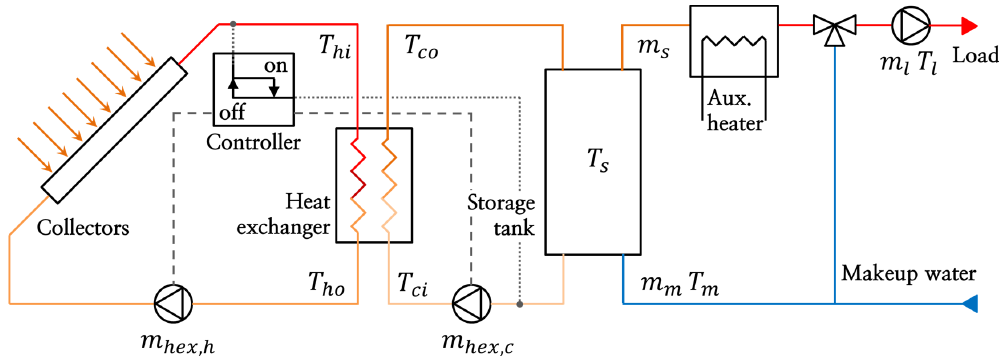
Figure 1. Schematic diagram of indirect forced ‐ circulation SWH system used in this study.